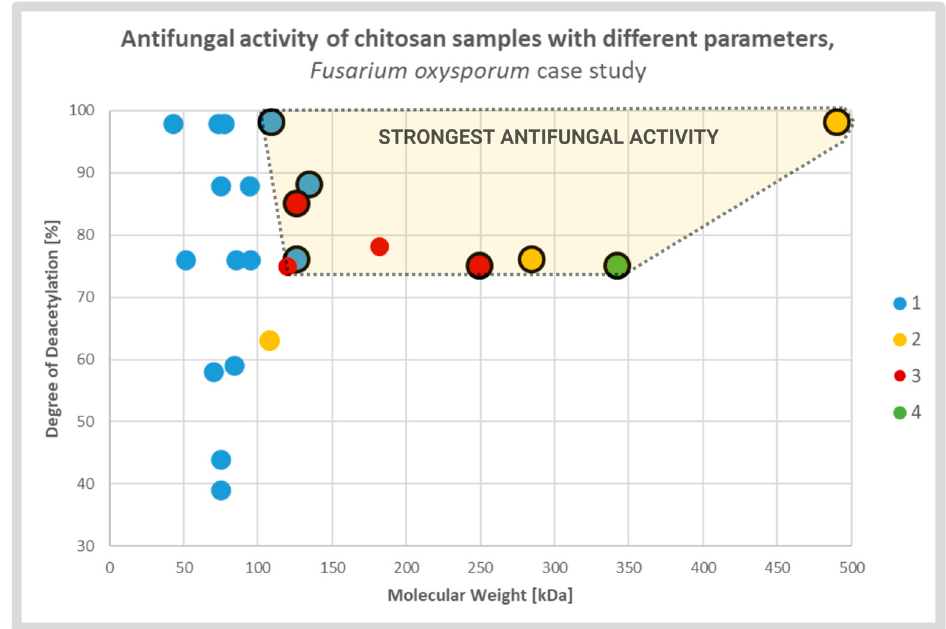
Figure 3. Scatterplot graph of antifungal activities of chitosan samples with different parameters tested on Fusarium oxysporum . Chitosan samples showing the strongest antifungal activities are encircled and highlighted. The colors and respective numbers indicate the cited articles: 1 [13] 2 [27] 3 [54] 4 [55].